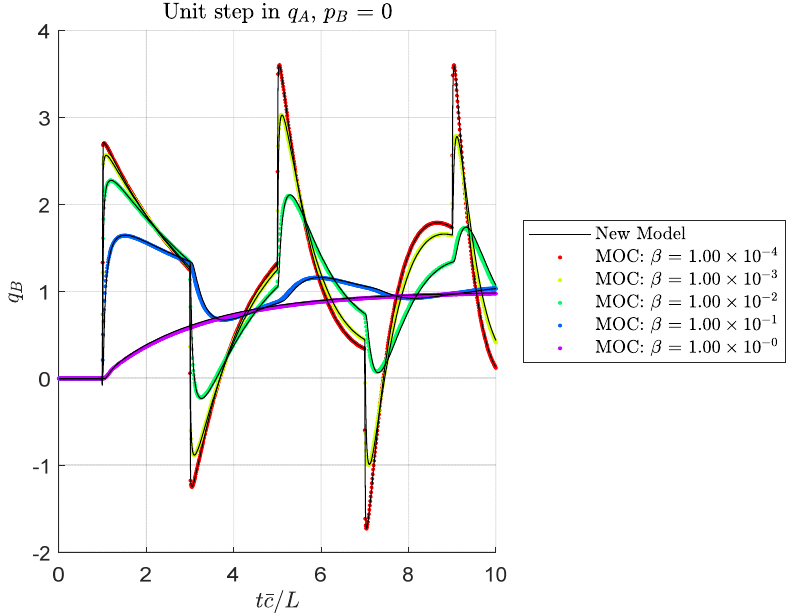
Figure 10. Outlet flow response to a unit step in inlet flow for an open exit, showing the effect of dissipation number (for c B c A = 0.5 ).